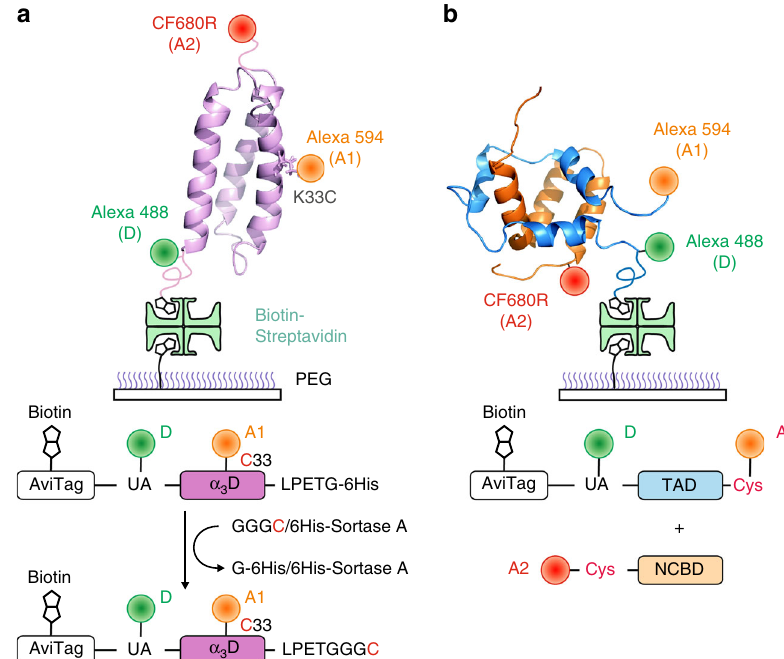
Fig. 2 Three-color FRET in protein folding and binding. a Three different fl uorophores are attached to α 3 D site-speci fi cally. Alexa 488 (donor, D) and Alexa 594 (acceptor 1, A1) are attached to 4-acetylphenylalanine (UA) at the N-terminus and cysteine at residue 33, respectively. Then, a cysteine residue is attached to the C-terminus using sortase-mediated ligation of a short peptide GGGC. This cysteine residue is labeled with CF680R (acceptor 2, A2). The labeled protein is immobilized on a polyethyleneglycol (PEG)-coated glass surface using biotin-streptavidin linkage. In two-color FRET, site-speci fi c labeling of two fl uorophores is not usually necessary because the two species with the different donor and acceptor positions would not cause a signi fi cant difference in the FRET ef fi ciency unless fl uorescence quenching occurs at one of the two labeling positions. In three-color FRET, however, when A1 and A2 are switched, for example, the distances between D and A1 and between D and A2 become different. b D and A1 are attached to 4-acetylphenylalanine and cysteine residues at the N- and C-termini of the transactivation domain (TAD), respectively, which is immobilized on the surface. TAD is incubated with A2-labeled NCBD in solution at a concentration close to the dissociation constant to monitor binding and dissociation